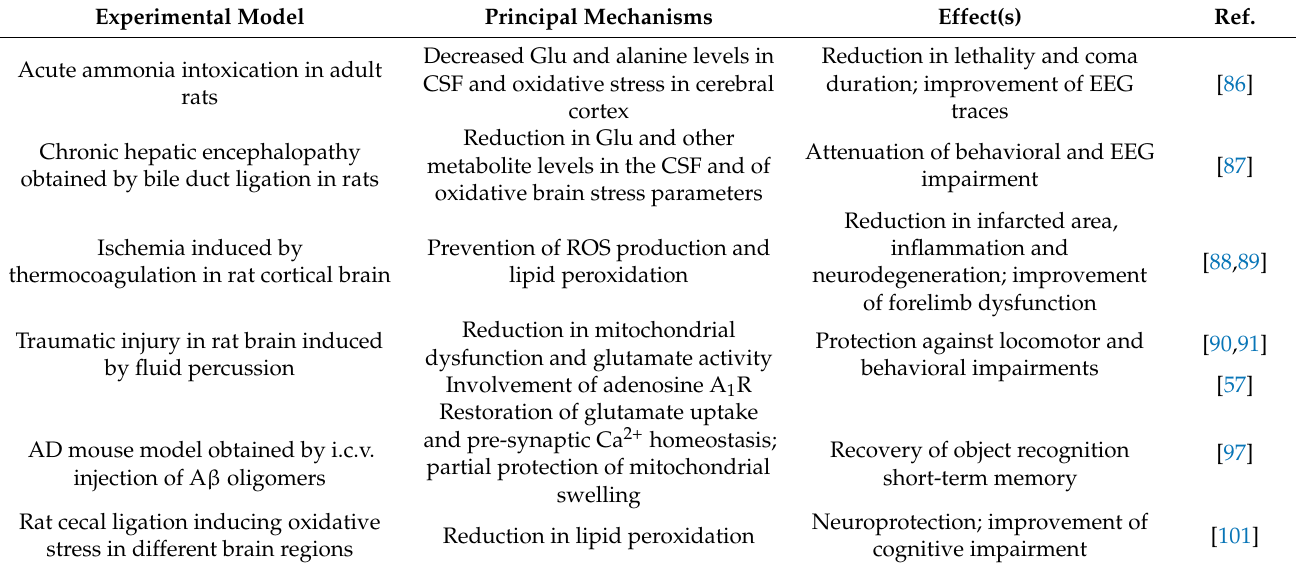
Table 2. GUO neuroprotective activity coupled to antioxidative properties in in vivo